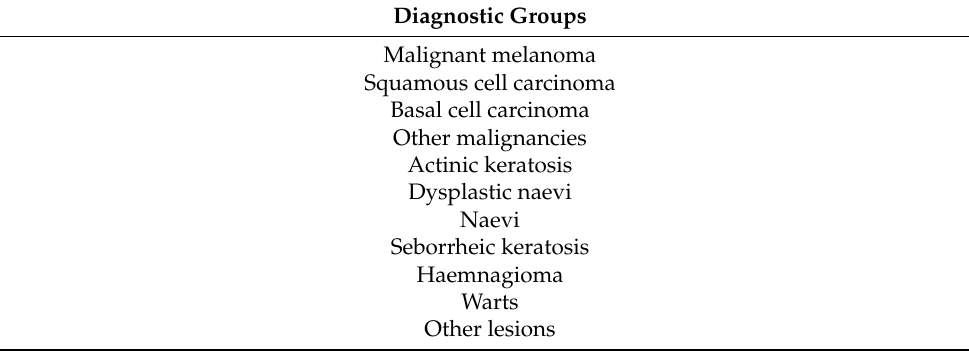
Table 1. List of diagnostic